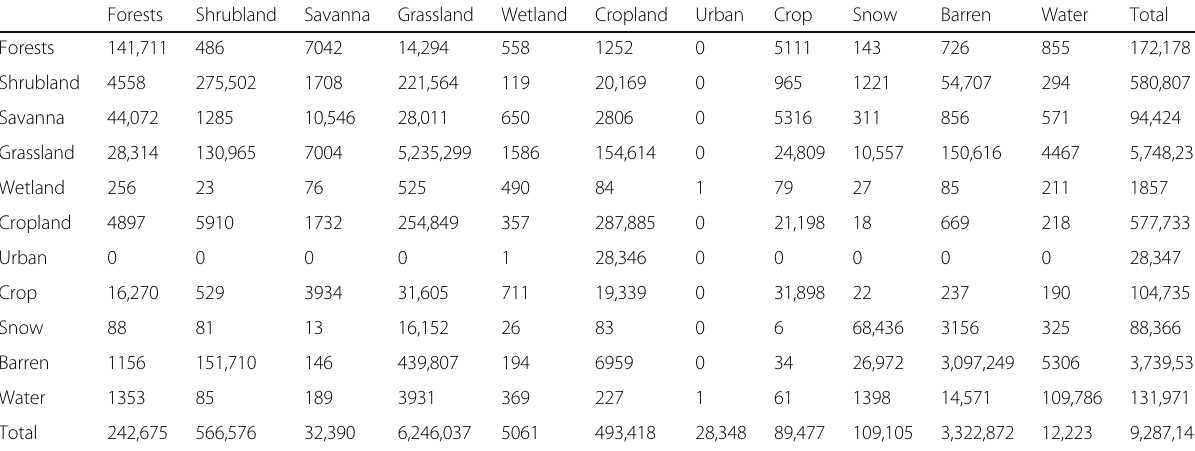
Table 1 Transformation matrix (km 2 ) of land cover/use in the Asian Dryland Belt (ADB) from 2001 (columns) to 2012 (rows)